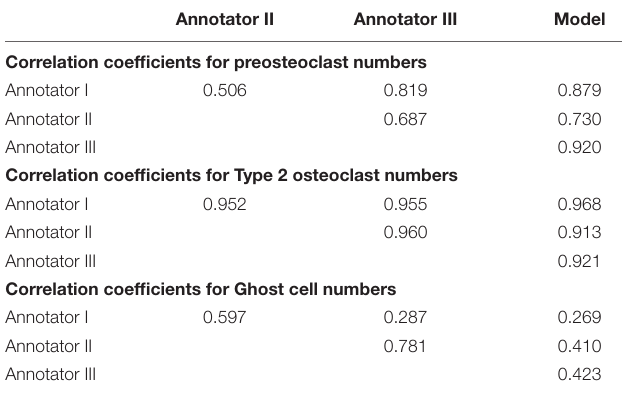
TABLE 2 | Correlation coefficients between human annotators and the model for cell area